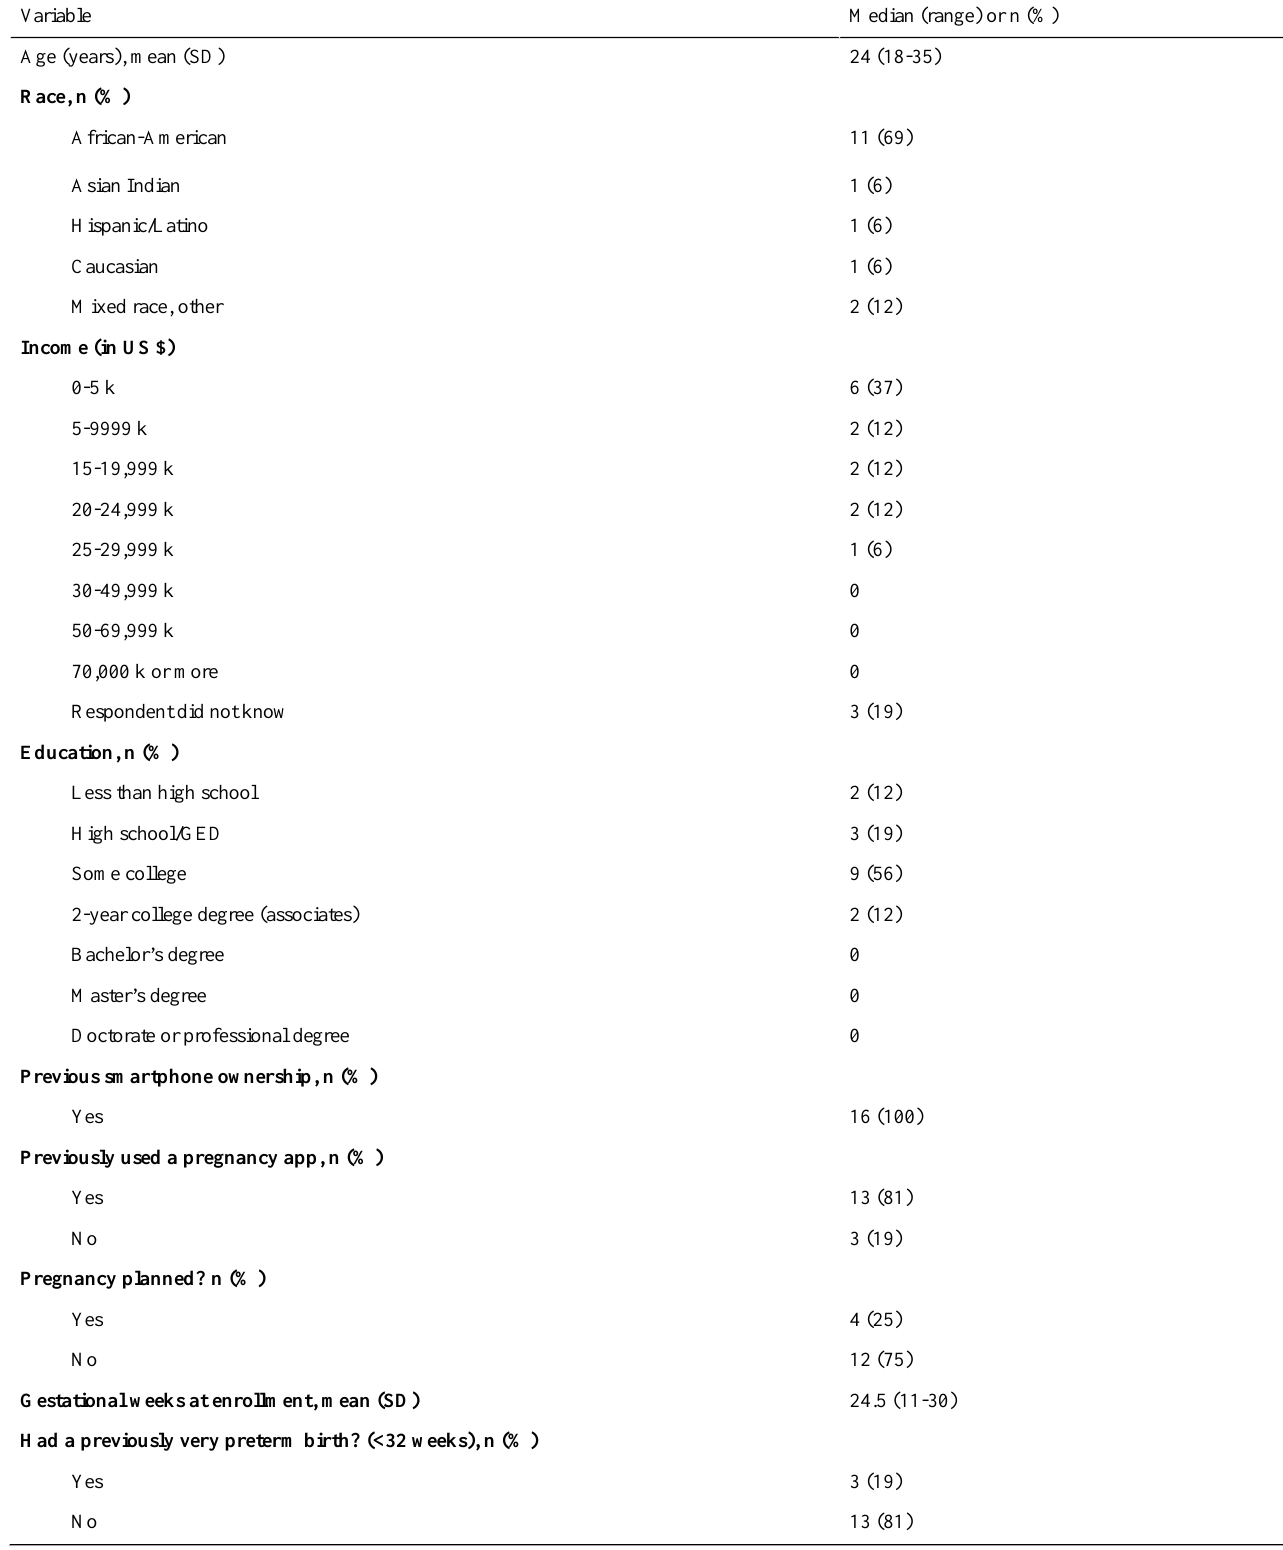
Table 3. Proof-of-concept pilot self-reported demographics